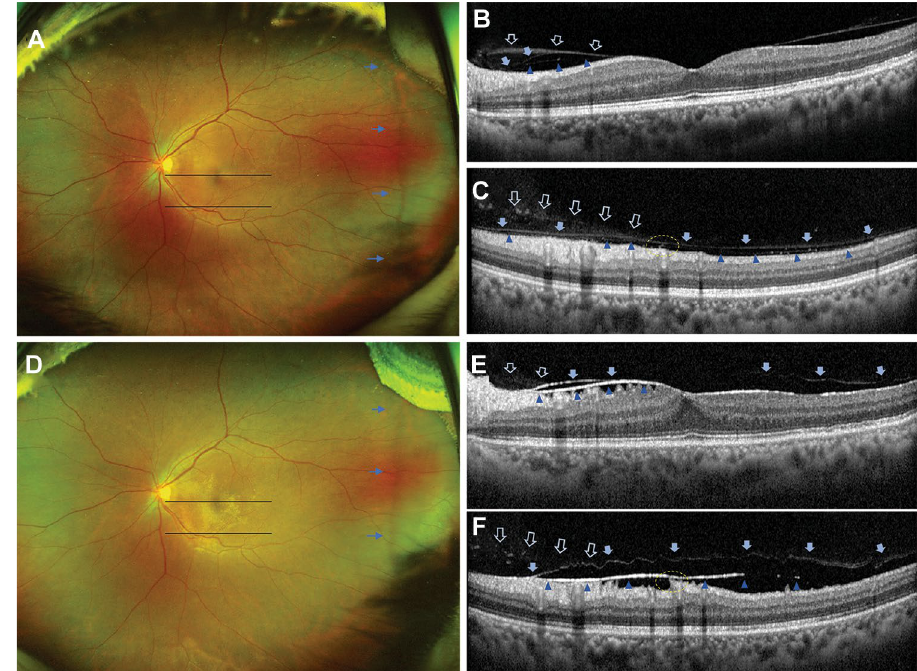
Figure 3. Representative images from a 61-year-old woman at preoperative ( A – C ) and 1-year follow-up ( D – F ). ( A ) A discrete margin of different retinal reflectivity (DMDRR; arrows) was presented on ultra-widefield fundus photography (UWF-FP). Two black lines indicate the position of figures ( B ) and ( C ). ( B ) Spectral domain optical coherence tomography (SD-OCT) image on fovea shows partial posterior vitreous detachment (PVD) with vitreoschisis. Each type of arrows and arrowheads indicates the separated vitreous cortex and posterior hyaloid membrane (PHM). ( C ) SD-OCT image at the inferior peri-macular area shows vitreoschisis and hyperreflective foci (HF) on the inner retinal surface (dotted circle). ( D ) One year later, the epiretinal membrane (ERM) was detected on the fovea. A DMDRR (arrows) was detected on the more posterior retina than 1 year ago. Two black lines indicate the position of figures ( E ) and ( F ). ( E ) SD-OCT image on fovea shows stage 3 ERM. Note that the nasal ERM shows two lines of hyperreflective lines that present identical locations of the separated vitreous cortex (arrows) and PHM (arrowheads) in figure ( B ). ( F ) SD-OCT image at the inferior peri- macular area shows ERM that locates at the identical location of PHM in figure C (arrowheads). Retinal tissues were dragged to the ERM at the location where the HF was detected (dotted circle) in figure ( C